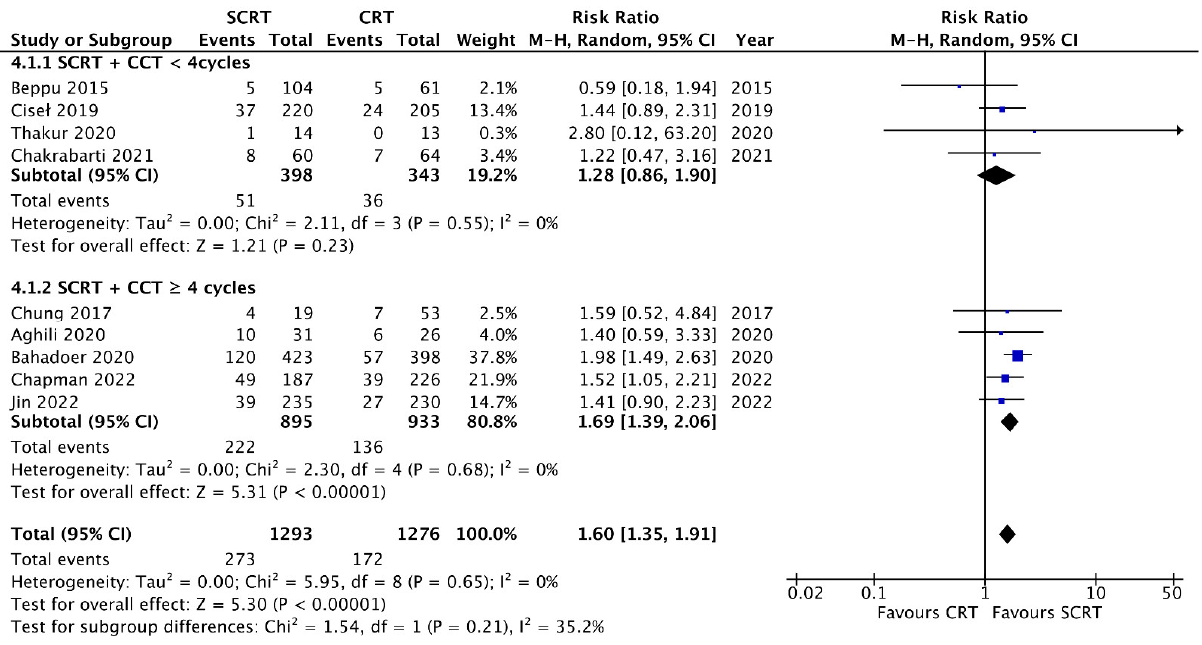
Figure 9. Forest plot for subgroup analysis of the pathological complete response (pCR) according to consolidation chemotherapy cycles.